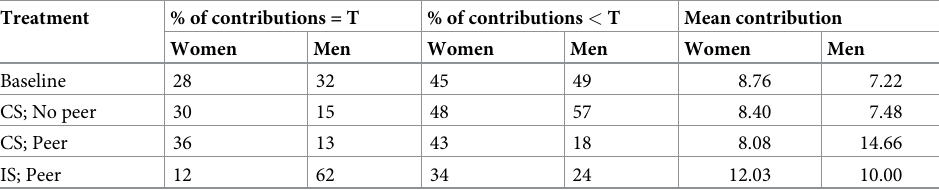
Table 4. Gender differences in